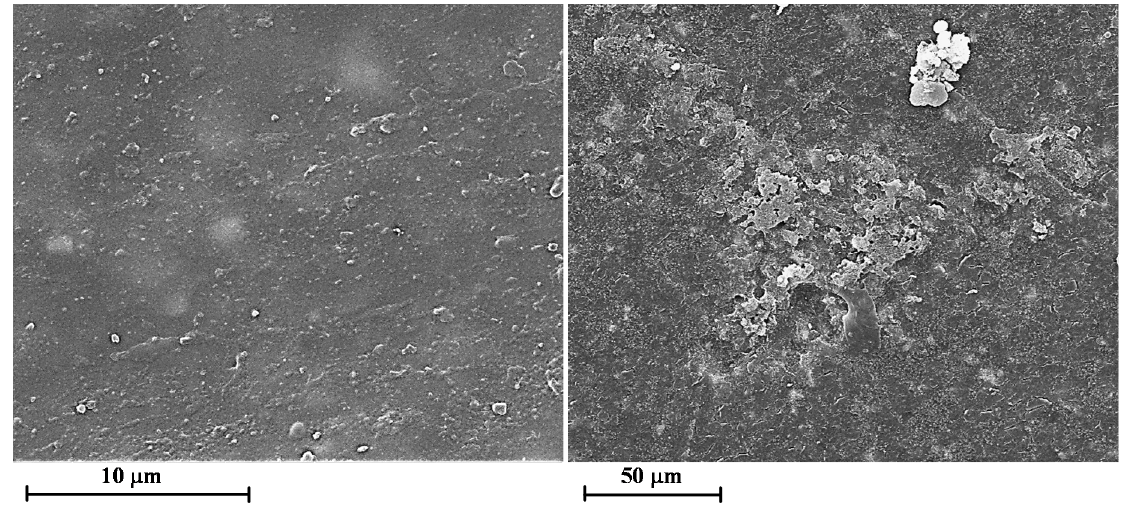
Figure 8. SEM micrographs of the film loaded with 0.1 wt.% of GNPs after 550 h of UV irradiance (01GNPs (550) sample) at different magnifications.